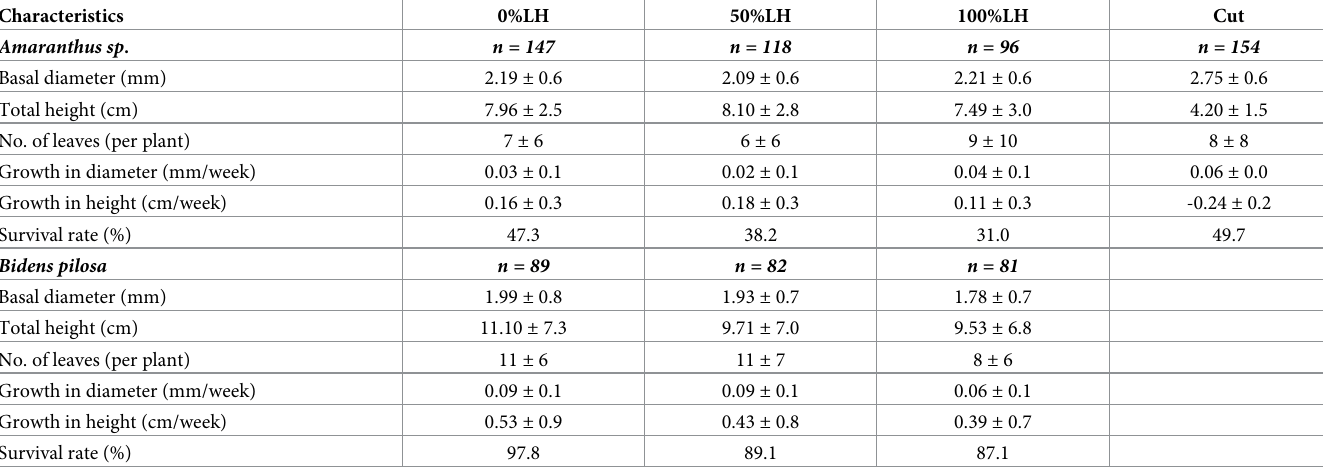
Table 5. Mean values of the considered characteristics ( ± SD) of the study species between harvesting treatments, after first harvest. Characteristics